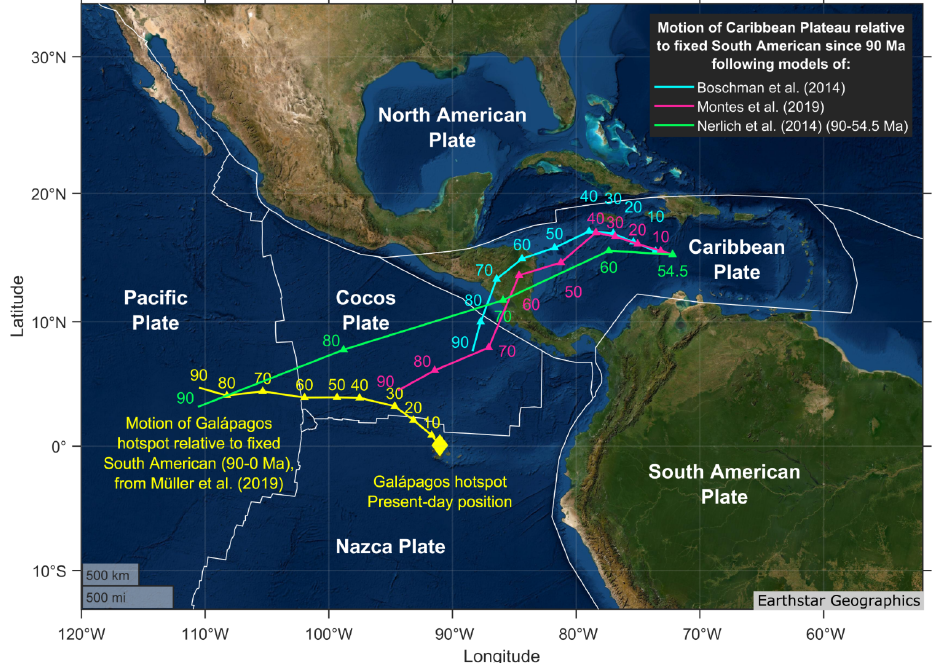
Figure 12. Motion paths of the Caribbean plate relative to the South American plate (SAM) for three recently proposed reconstructions. Motion of present-day Galápagos hotspot relative to a fixed SAM is shown in yellow. A fit with Galápagos hotspot at time of plateau formation (90Ma) is only obtained by Nerlich et al. (2014), assuming the Caribbean plate moving with Farallon plate from 90 to 54.5Ma and fixed to SAM since 54.5Ma. Regional reconstructions based on geological and geophysical datasets from the entire Caribbean region (Boschman et al., 2014) and the north-western Andes (Montes et al., 2019a, b), however, show very different motion paths for the Caribbean plate relative to SAM and a clear offset with the Galápagos hotspot at